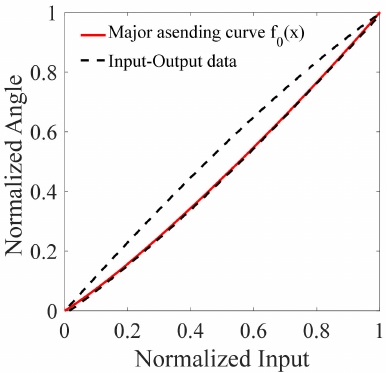
Figure 12. Input-output data and identified major